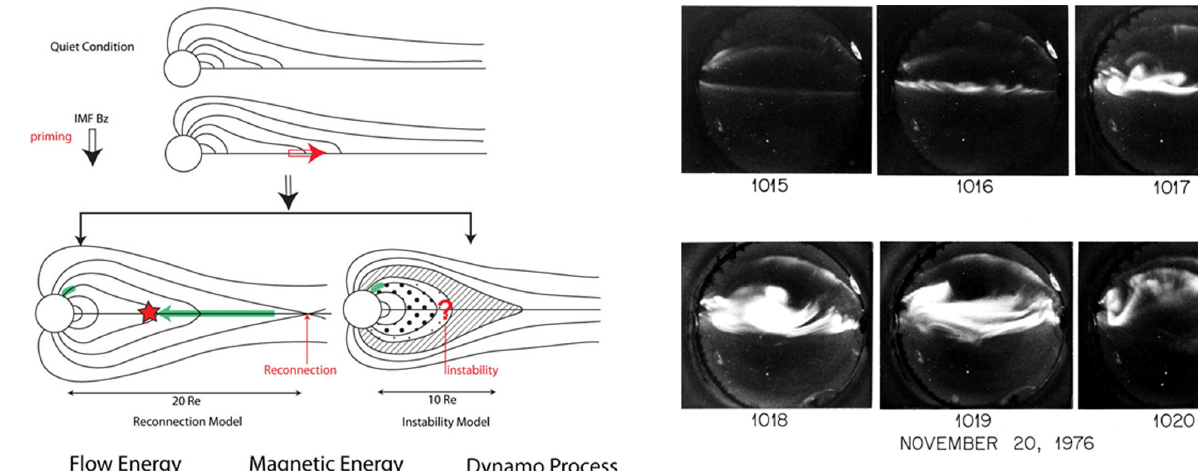
Fig. 17a. Schematic illustration of two models which cause substorms.